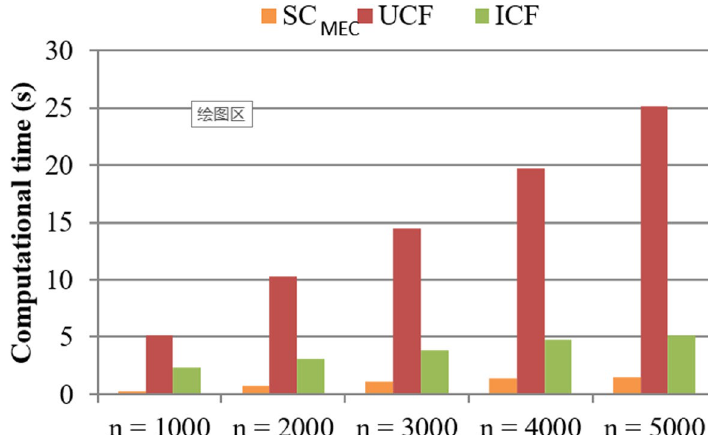
Fig. 3 Computational time comparison (w.r.t. n )